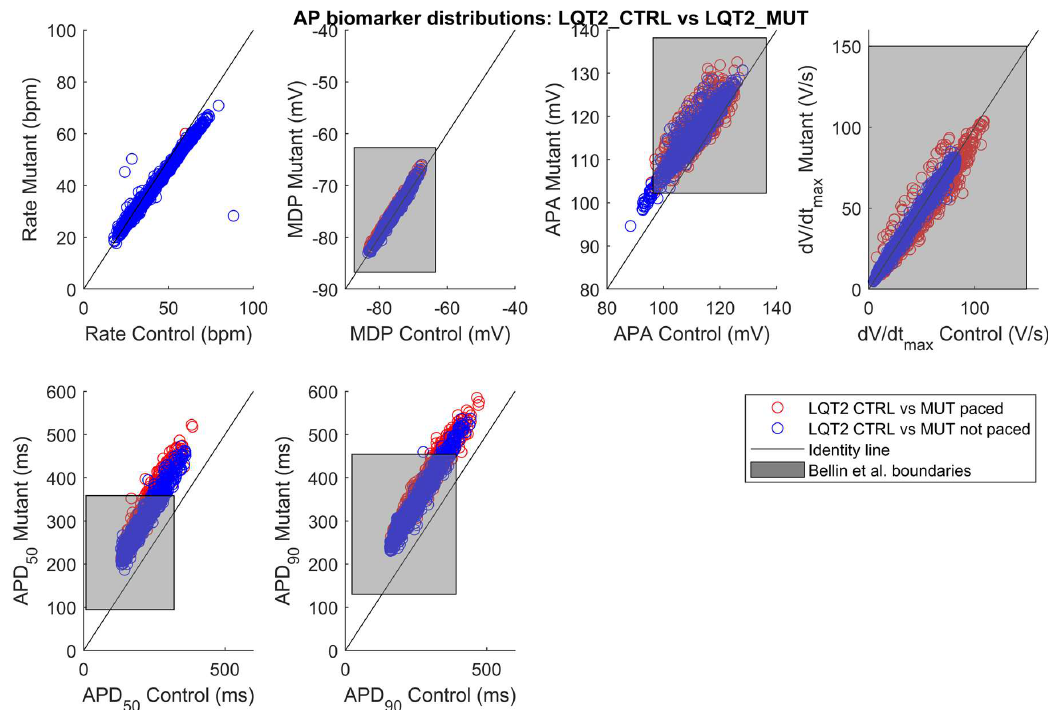
Figure 7. AP biomarker distributions in the populations LQT2_CTRL vs. LQT2_MUT in the non-paced (blue circles) and paced (red circles) cases. The black lines represent the identity lines, i.e., when the AP biomarkers are equals in LQT2_CTRL and LQT2_MUT. The grey rectangles represents the boundaries built on the experimental AP biomarkers from the Bellin 2013 control and mutant datasets [4] recorded in paced hiPSC-CMs and reported in Table 3: lower bound (mean − 2SD) and upper bound (mean + 2SD) for each AP biomarker except for the Rate biomarker (pacing rate set to 60 bpm).